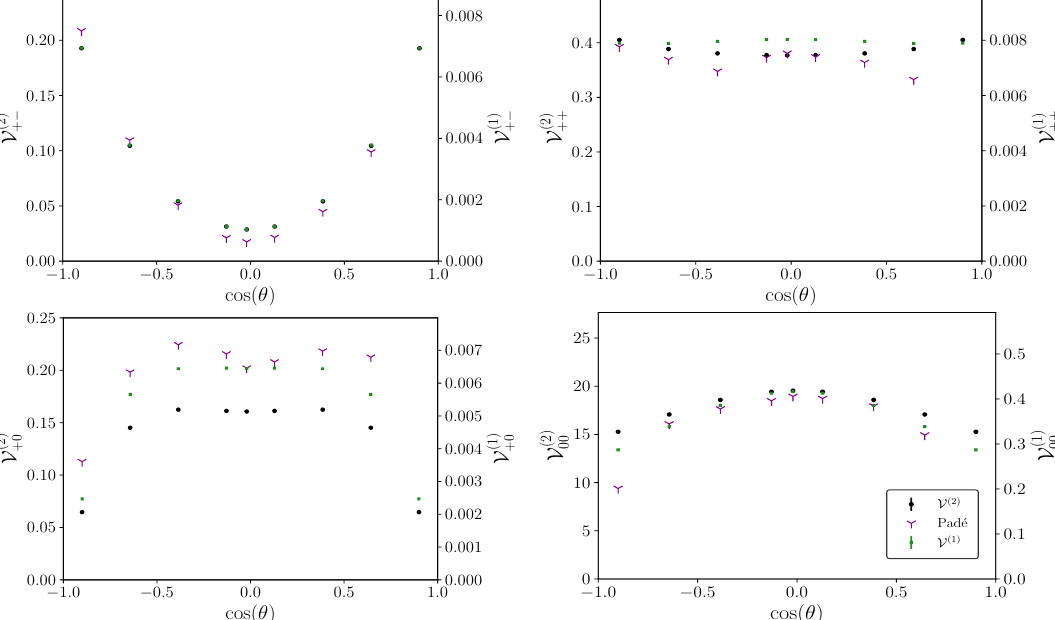
Figure 11. The cos( θ ) dependence of 1-loop and 2-loop interferences for polarised ZZ production √ in gluon fusion at s/m t = 2 . 331 . The Padé improved small top-quark mass expansion [36] is shown for comparison.